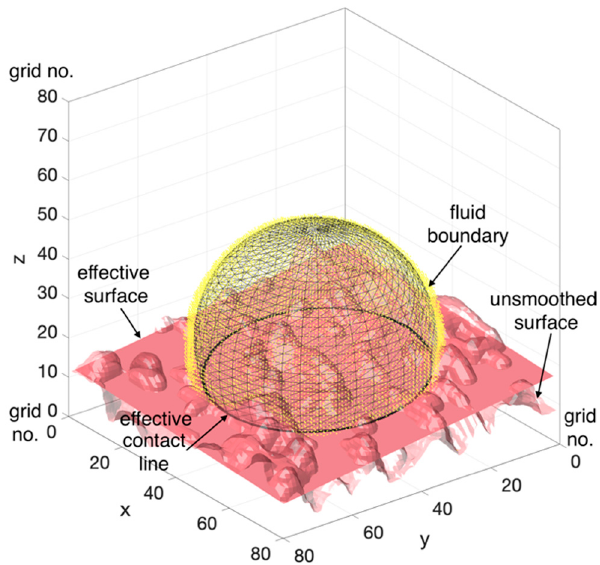
Figure 5. Least-squared spherical fitting over a density image generated by segmenting the simulation box into 80 × 80 × 80 cube voxels and classifying the voxels with more than 5 fluid particles per nm 3 as fluid filled. A Gaussian filter is used to smooth the image and a median filter is applied to remove the isolated fluid voxels. The contact angle is measured within the fluid phase, between the fitted sphere and the effective flat surface.